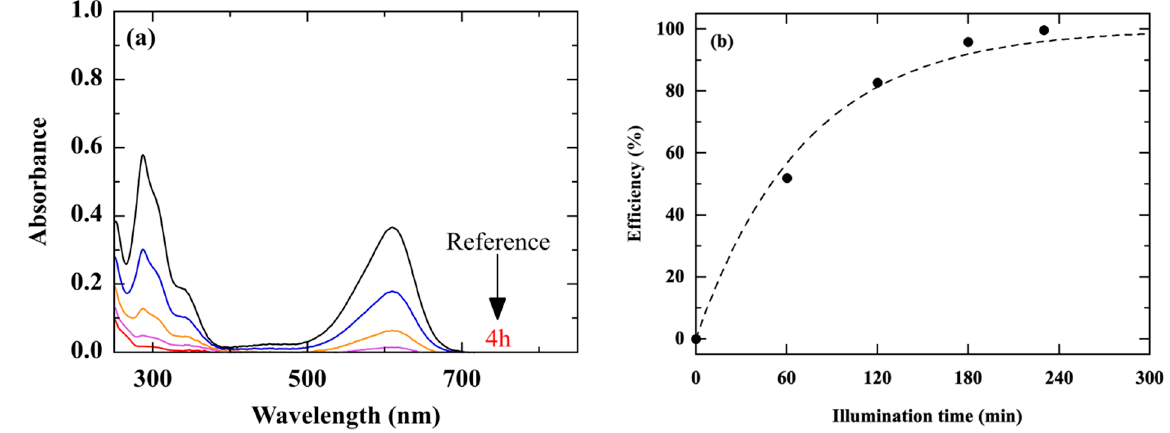
Figure 16. Absorbance spectrum ( a ) and photodegradation efficiency ( b ), over time, of a Somme water-based IC solution under solar irradiation and in the presence of a ZnO/Ag(10% NPs) photocatalyst.